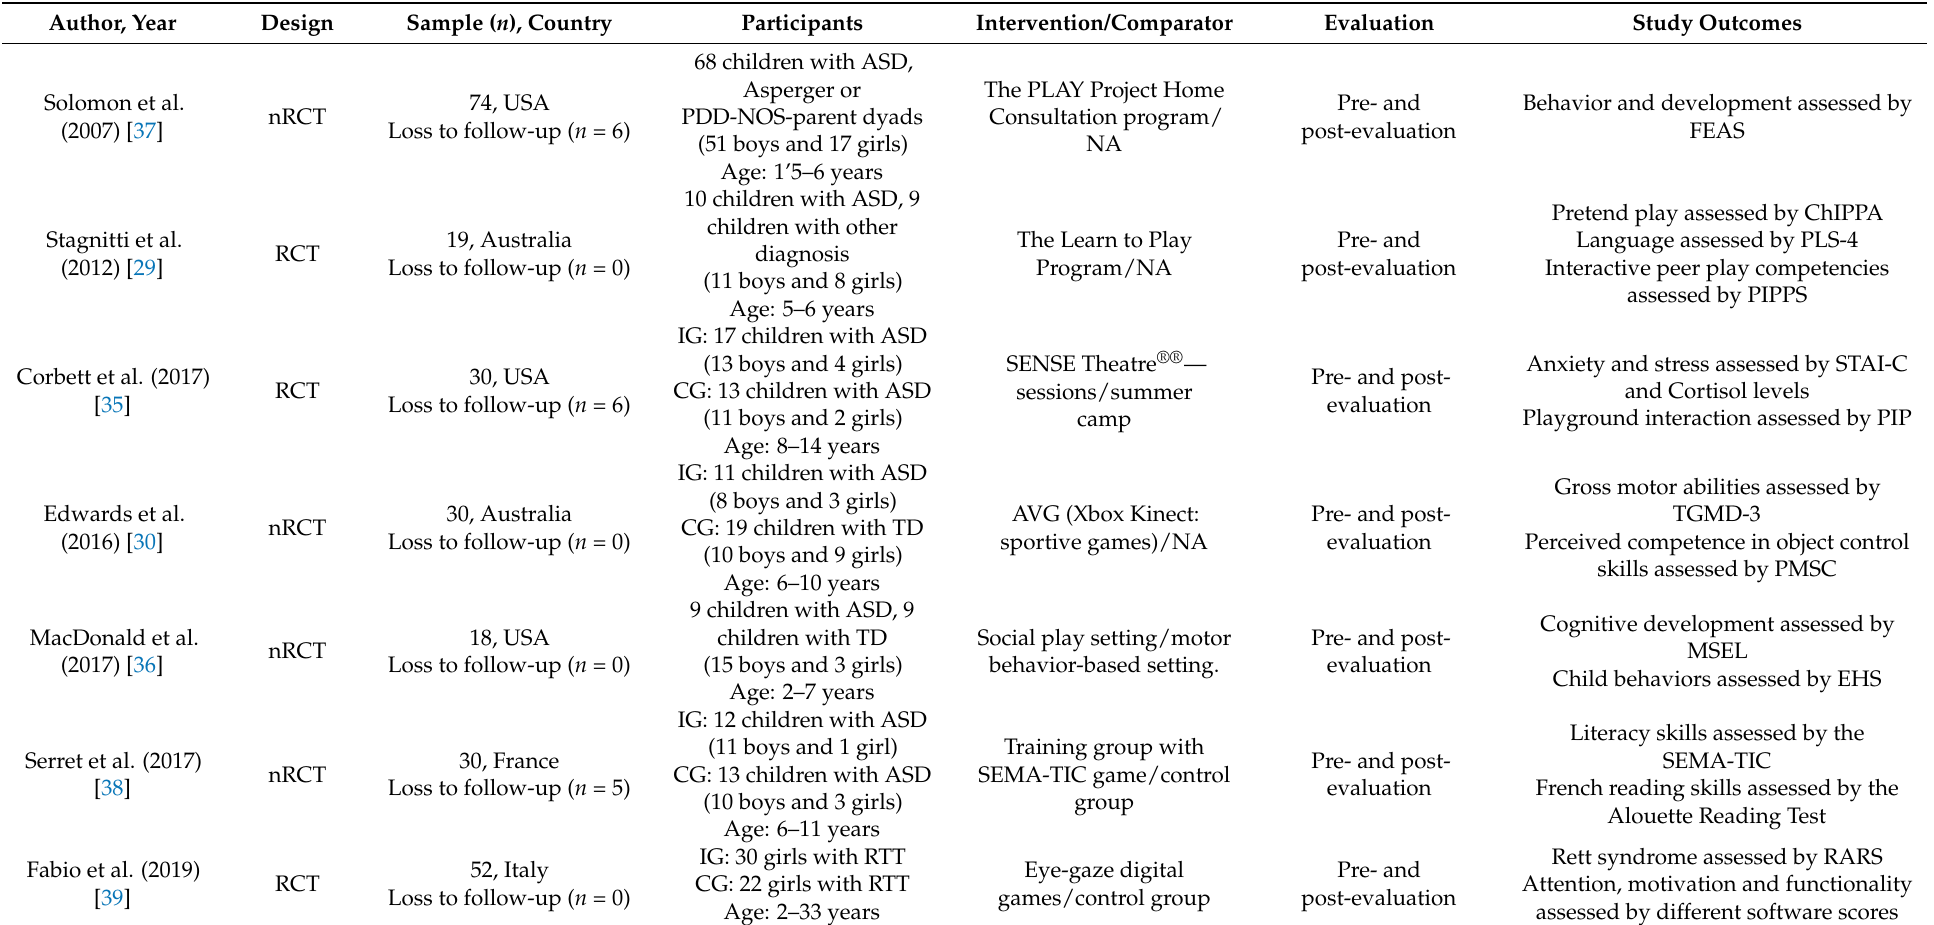
Table 2. Characteristics of the studies included in this scoping